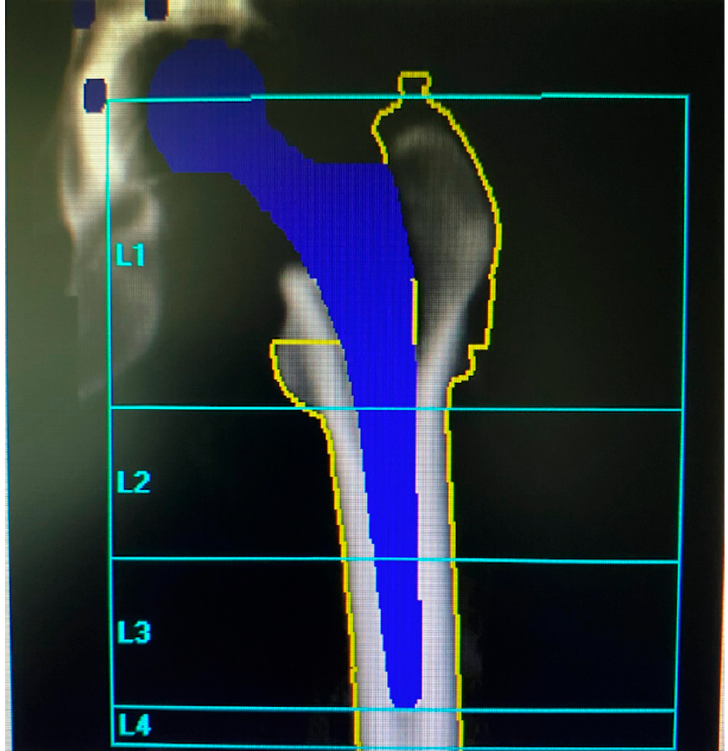
Figure 2. Preoperative DEXA scan of modified Gruen zones using a template.